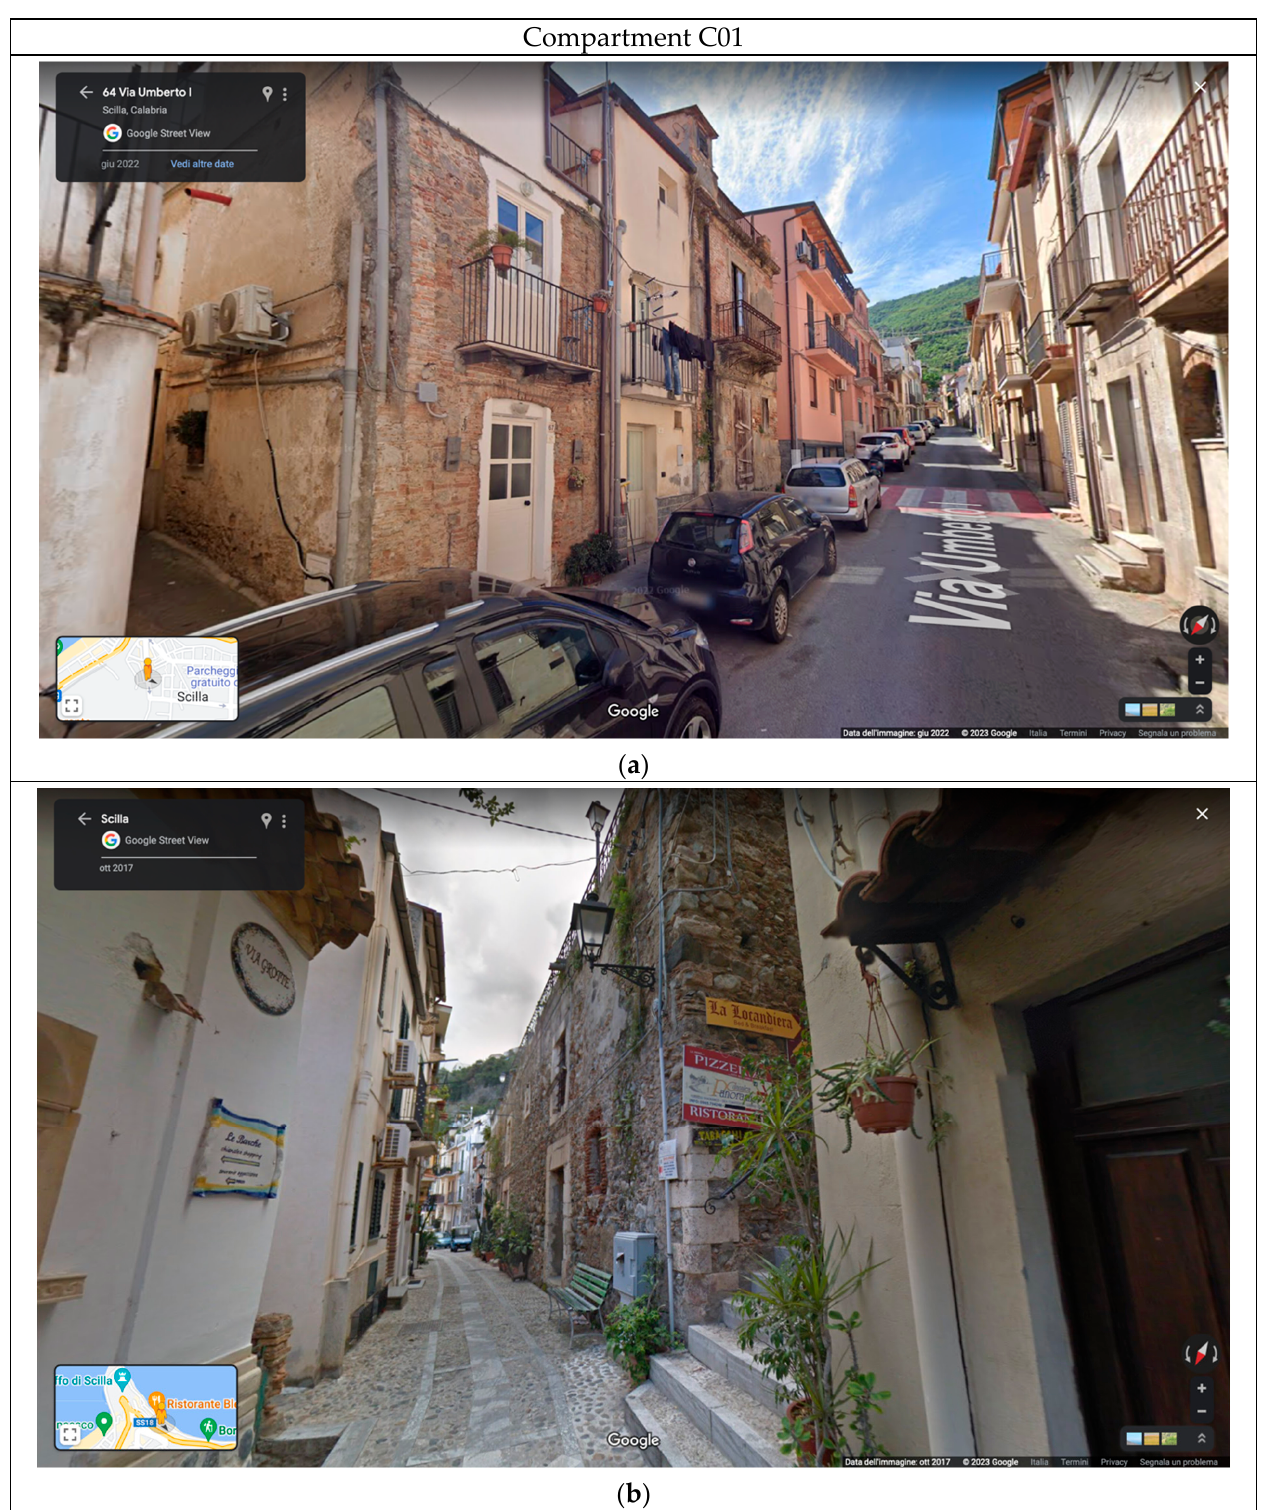
Figure 5. Digital survey of the buildings of Compartment C01 of Scilla via Google Maps. ( a ) https://goo.gl/maps/XMb6JVtWkUS7M8Ws5 (accessed on 19 January 2023), ( b ) https://goo.gl/maps/ bcgFxVDfVDPyewaV9 (accessed on 19 January